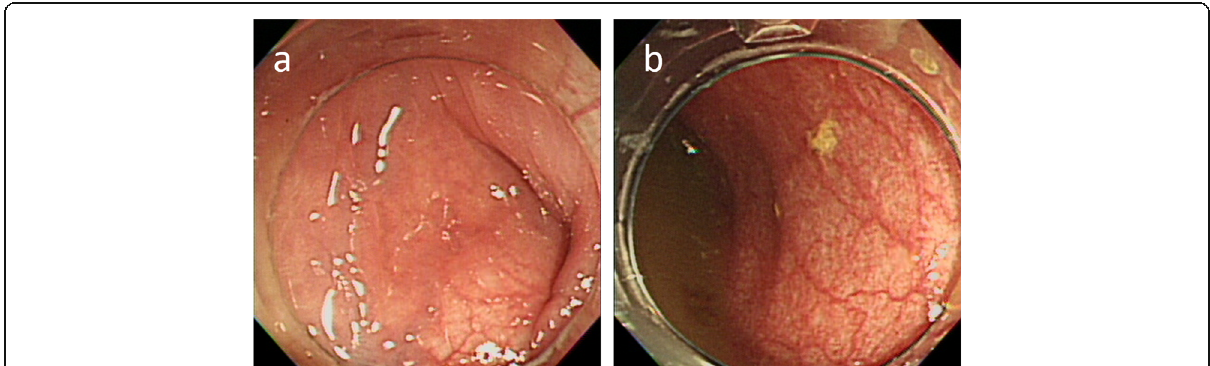
Fig. 2 Endoscopic findings before the first surgery. There was an obstructed area of the transverse colon ( a ), and the scope managed to pass through the lesion. The oral side of the colon was dilated and contained with feces. The wall was conjugated and swollen, but no ischemic change was observed ( b )